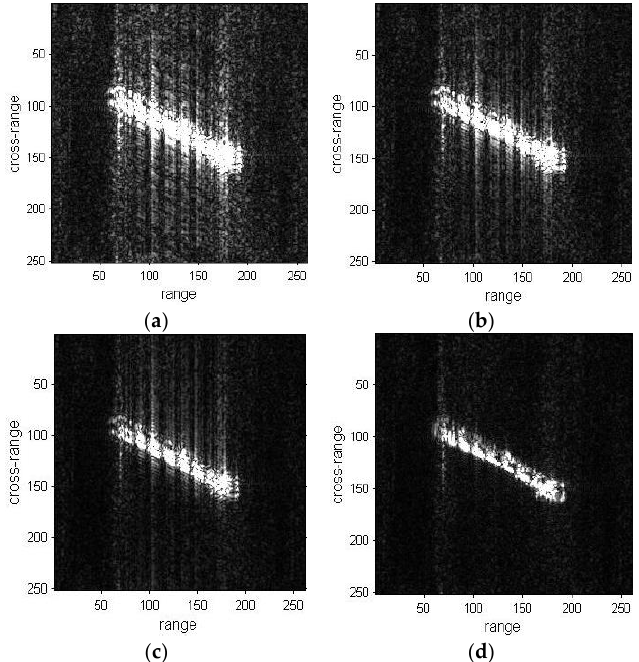
Figure 12. Refocused images of ship04 sub-image. ( a ) Sub-image of ship04; ( b ) Refocused image with DCT method; ( c ) Refocused image with PGA method; ( d ) Refocused image with proposed method.